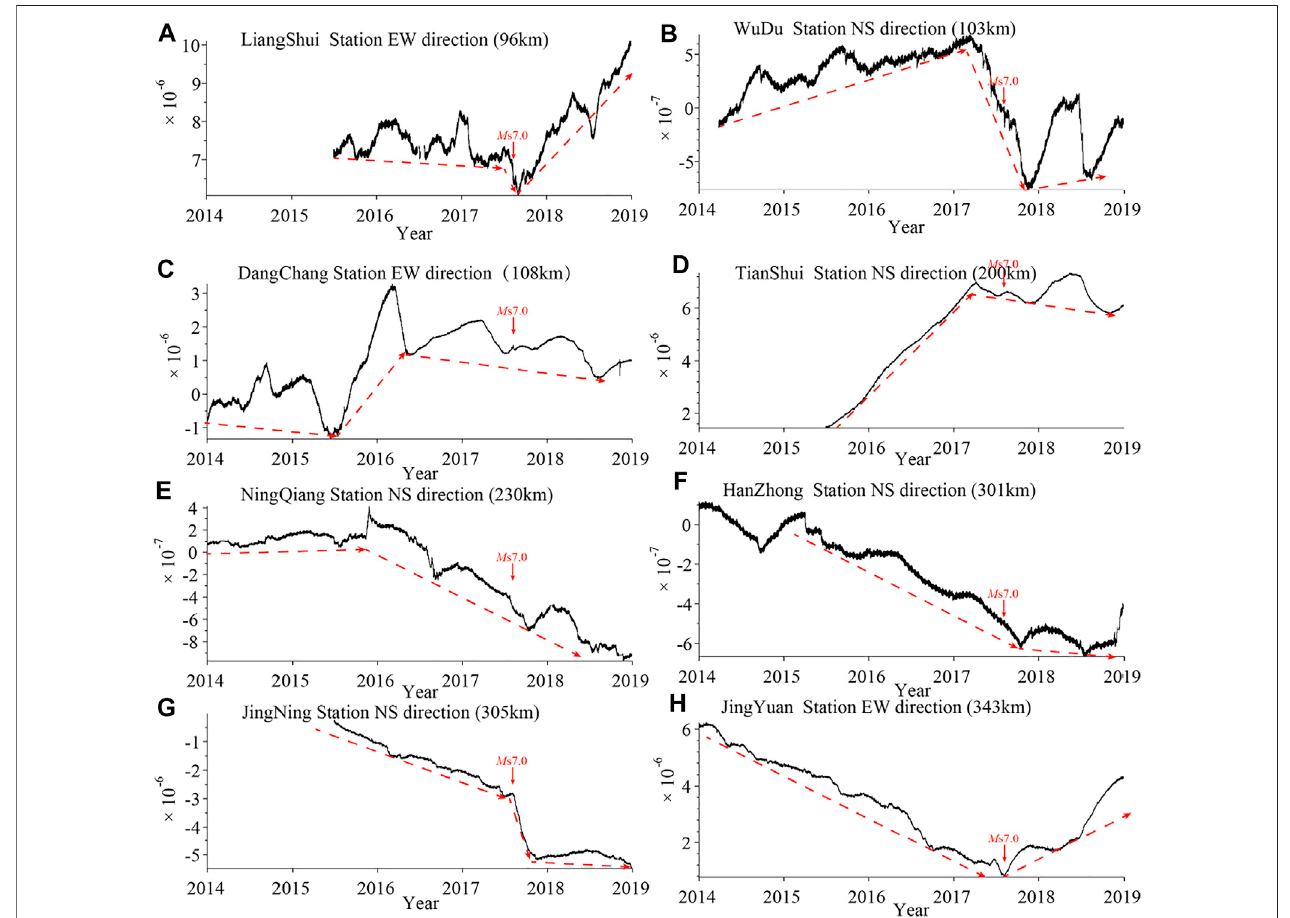
FIGURE 2 | Time series curves of strain observations at eight stations near the